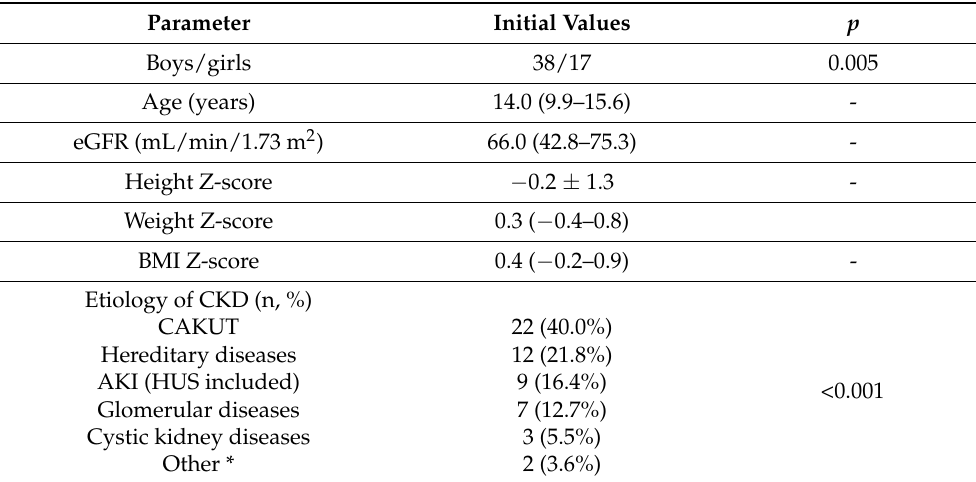
Table 1. Clinical and anthropometric parameters at the beginning of the observation